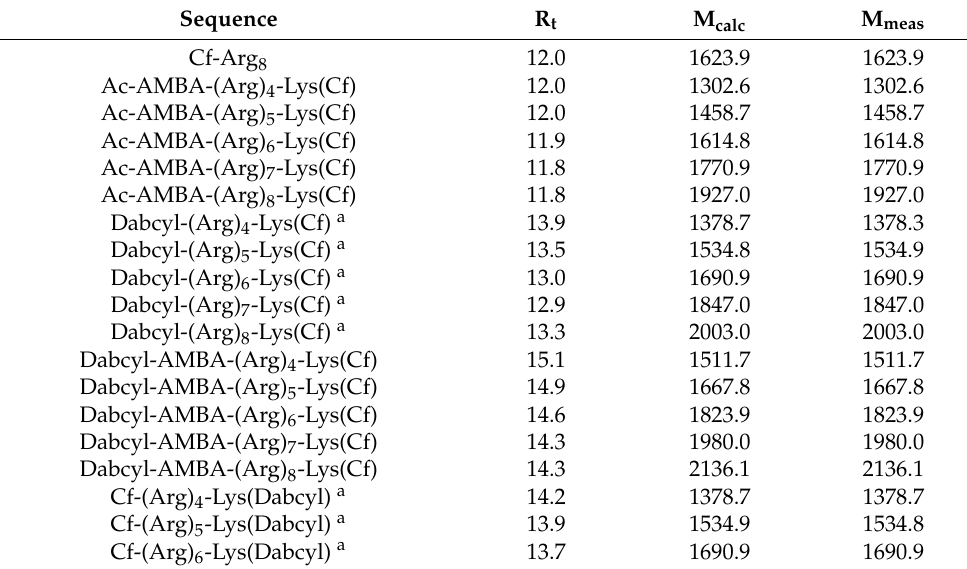
Figure 1. Structures of ( a ) Dabcyl, ( b ) AMBA, and ( c ) the Dabcyl-AMBA-peptides. The characterization of the purified peptide conjugates was performed by analytical RP-HPLC and ESI-MS (Table 1; the analytical RP-HPLC chromatograms and MS spectra can be found in the Supplementary Materials, Figures S1–S38). Table 1. Chemical characterization of the